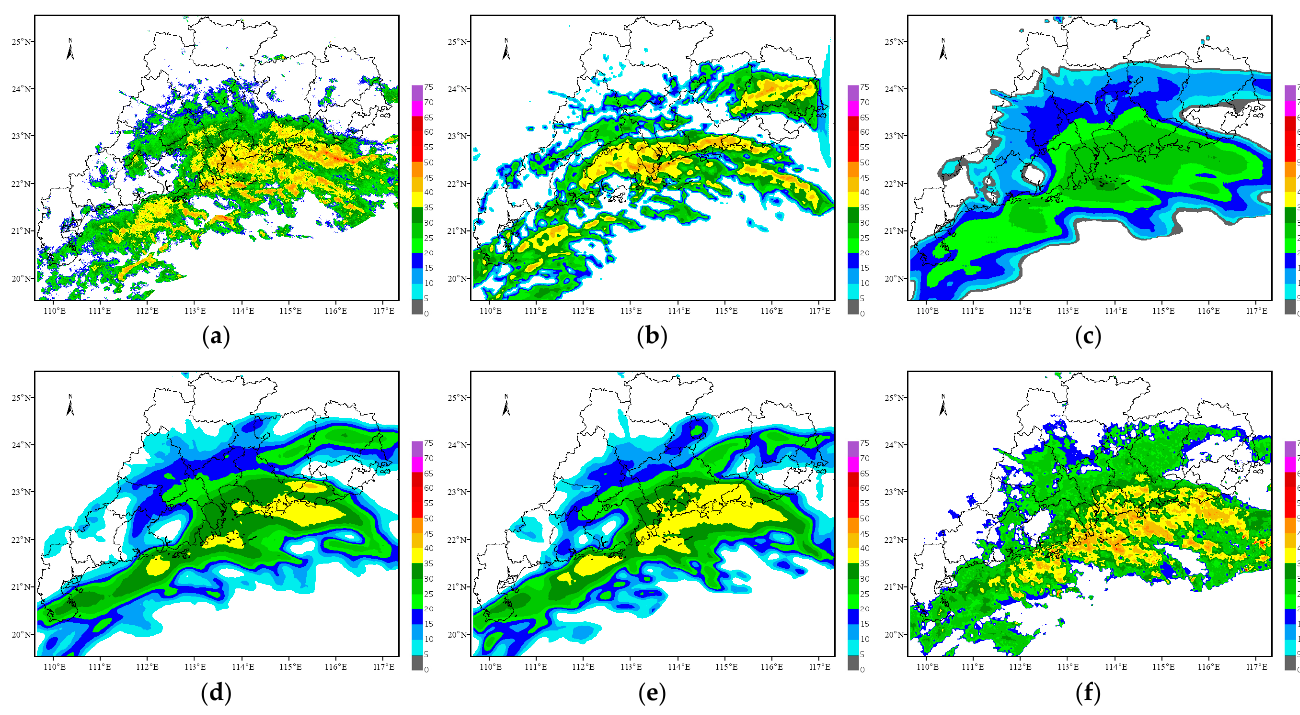
Figure 13. Nowcasting results of the typhoon process for the next 2 h. ( a ) Observation; ( b ) Opticalflow; ( c ) ConvGRU; ( d ) PredRNN; ( e ) PredRNN V2; ( f )